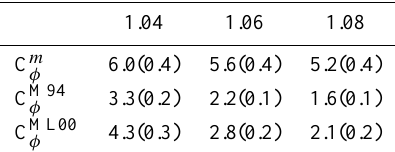
Fig. 6. Inferred total number of cells (a) and average popula- tion scattering cross-section at 550nm (b) as a function of time ( n = 1 . 06). Thick blue lines: median values; dark blue shaded ar- eas: central 68th percentile range (approximately equal to the stan- dard deviation for normal distributions); light blue shaded areas: 95% confidence intervals. The photosynthetically available radia- tion (PAR) is plotted as a thin black line. Table 6. Phytoplankton carbon (mgm − 3 ) inferred from model out- puts by means of the biovolume- m relationship, C m and from the φ model biovolume and the carbon-biovolume relationships by Mon- tagnes et al. (1994), C M94 , and Menden-Deuer and Lessard (2000), φ C ML00 φ